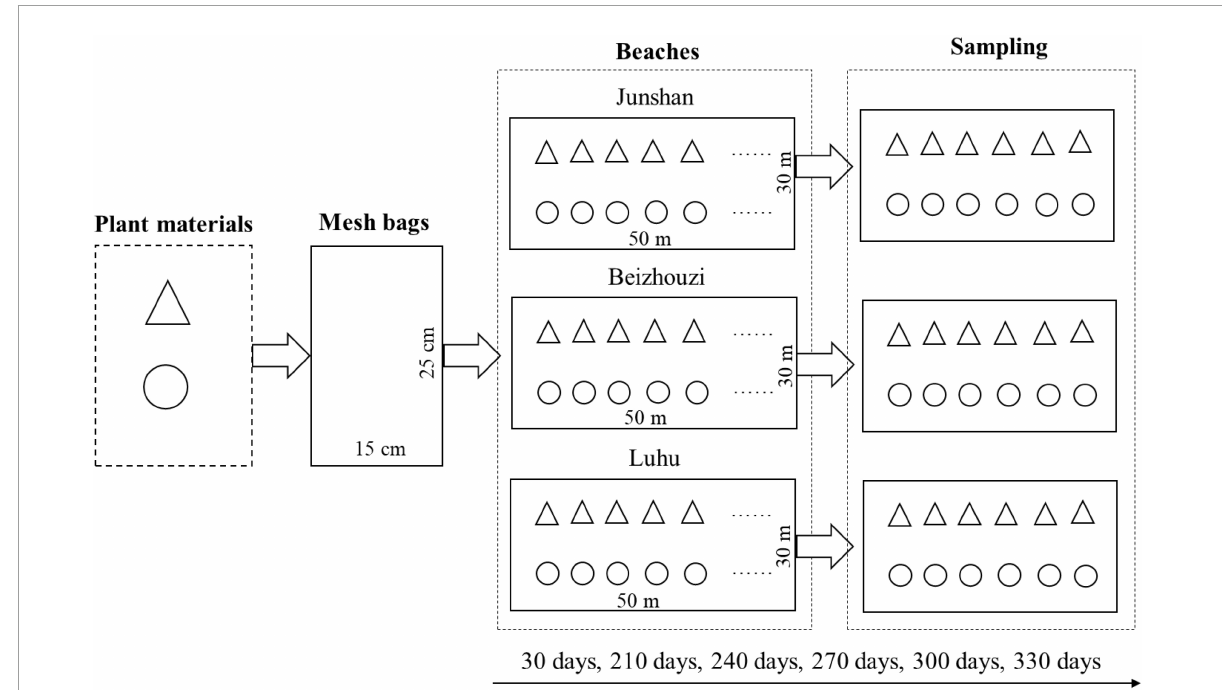
FIGURE2 Flow picture of the implementation of the in situ experiment (triangles, leaves; circles, stems).